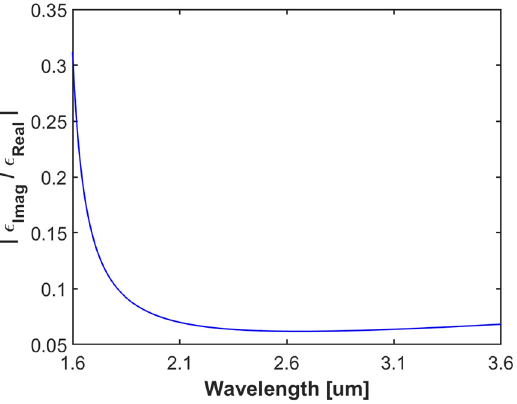
Figure 3. Permittivity component ratio | ε Imag / ε Real | of CdO as a function of the wavelength. To obtain the reflectance of the proposed hybrid multilayer structure, the general N-layer model [50] was employed by using the transfer matrix method [51] with N corre- sponding to the number of layers in the waveguide. There are six layers in our configuration, i.e., N = 6, i.e., two outer layers ( i = 1 for the prism and i = 6 for the analyte layer) and four inner layers. The individual transfer matrix for the inner layers ( i = 2 to N − 1) is given